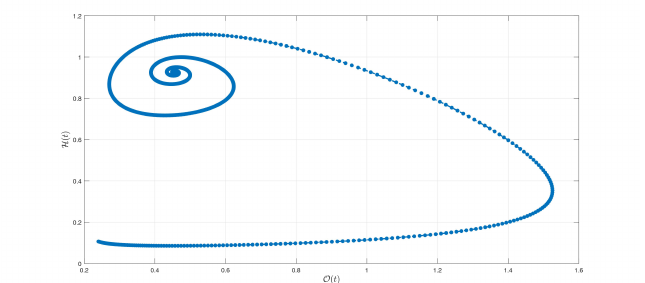
Figure 10. Behaviors of pair of sub-classes O ( t ) − H ( t )